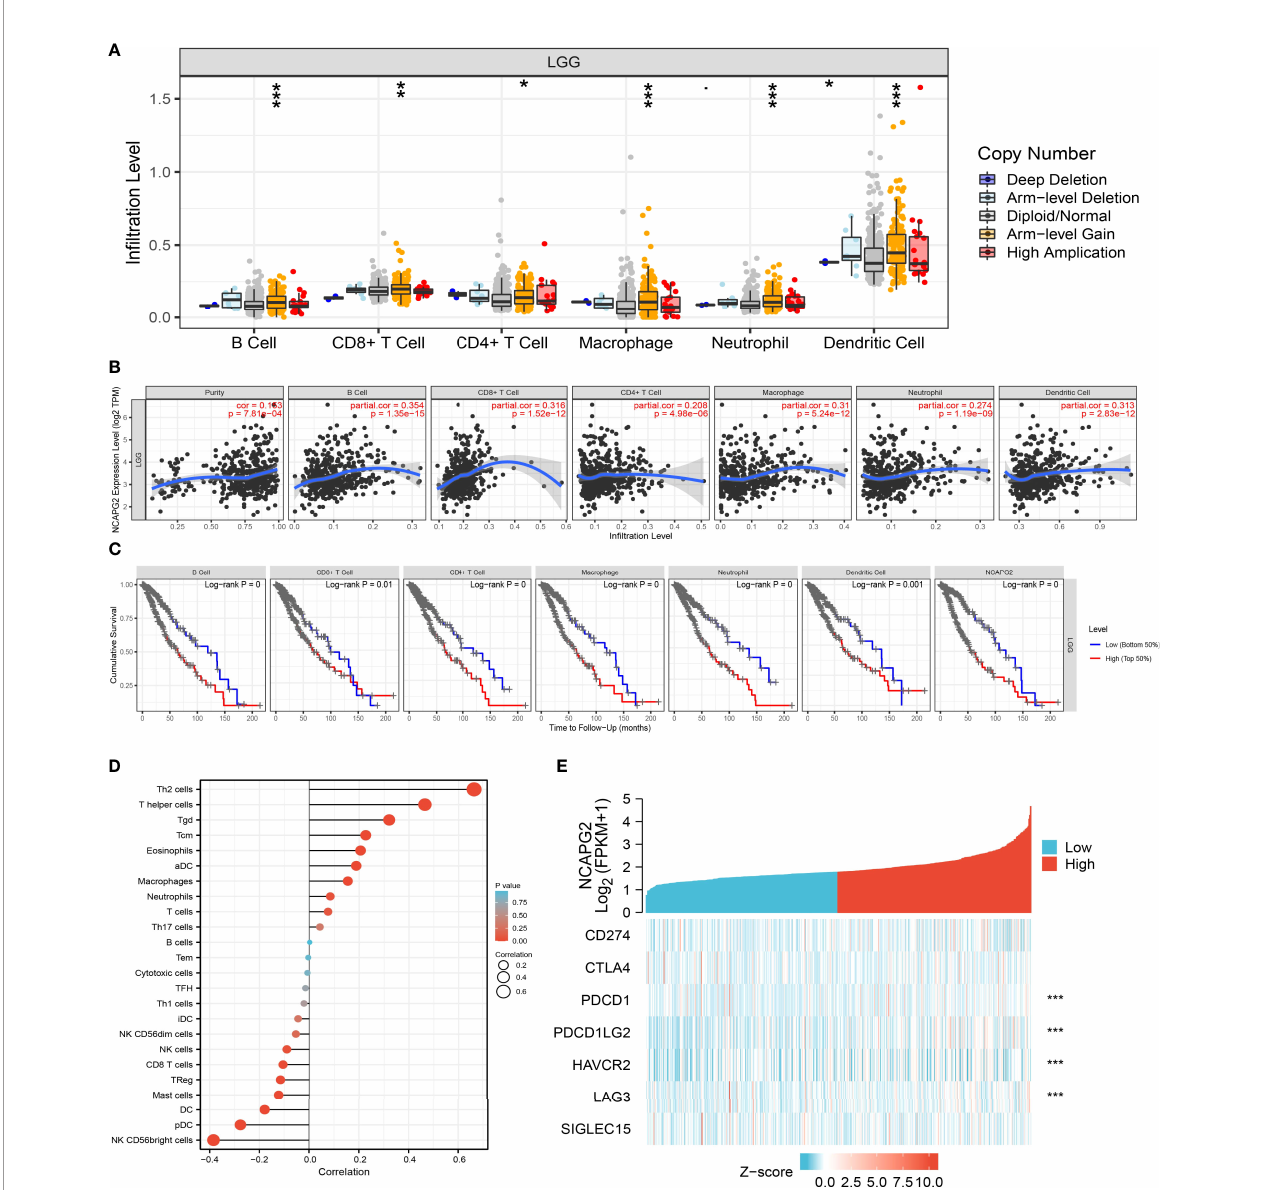
FIGURE 10 | Analysis of the correlation between NCAPG2 expression and diverse immune cell in fi ltration. (A) The correlation between NCAPG2 expression and somatic copy number alterations examine by TIMER. (B) The correlation between NCAPG2 expression and the in fi ltration levels of B cells, CD4+ T cells, CD8+ T cells, dendritic cells, Macrophages and Neutrophils. (C) The B cells, CD4+ T cells, CD8+ T cells, dendritic cells, Macrophages and Neutrophils are correlated with the cumulative survival rate in LGG examine by TIMER. (D) The correlation between NCAPG2 expression and 24 type immune cell in fi ltration. (E) The correlation between the NCAPG2 expression and various immune checkpoints related genes. P < 0.05 (*), P < 0.01 (**) and P < 0.001